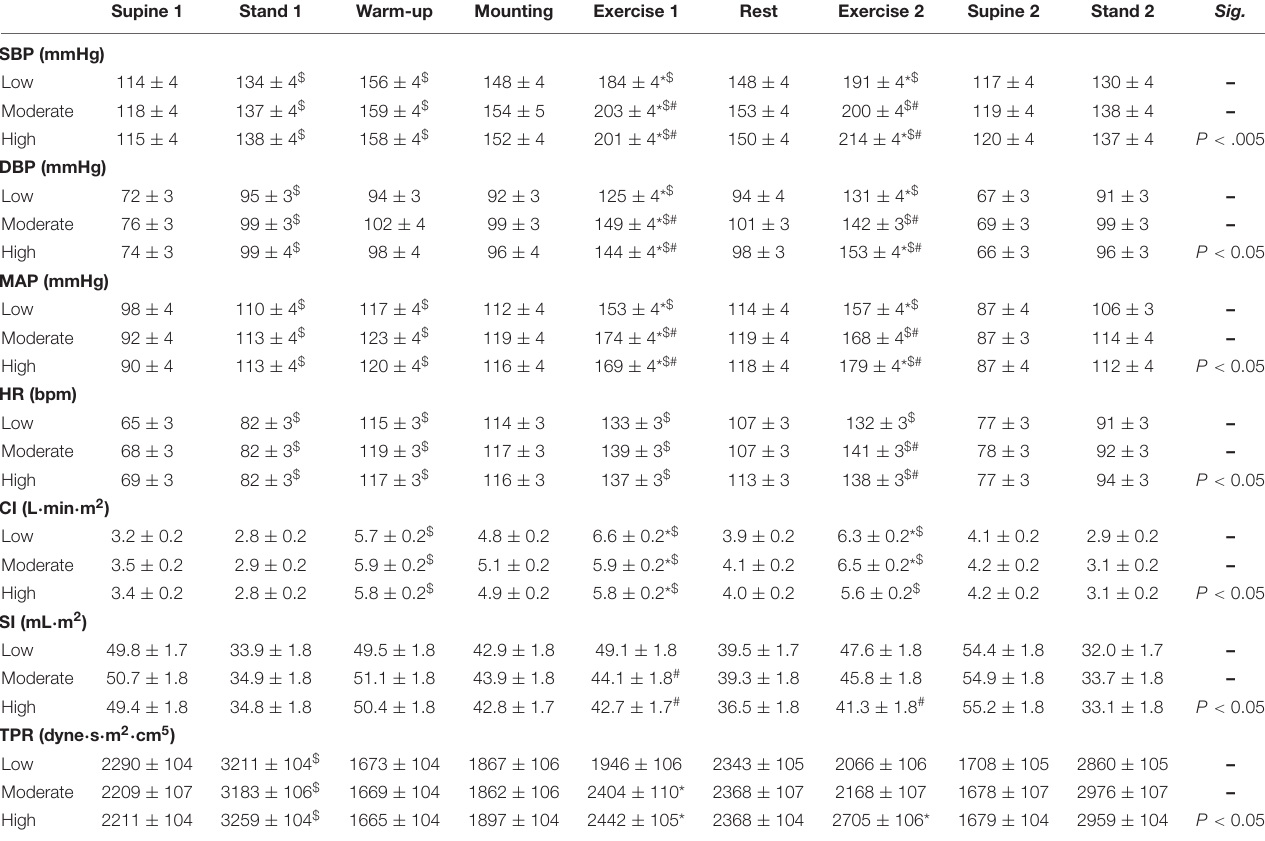
TABLE 3 | Maximal readings of the cardiovascular response to different levels of the flywheel exercise. Supine 1 Stand 1 Warm-up Mounting Exercise 1 Rest Exercise 2 Supine 2 Stand 2